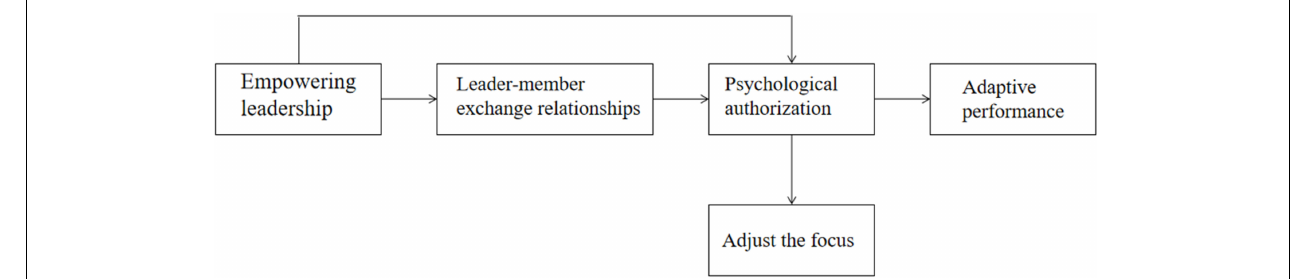
FIGURE 1 | Theoretical